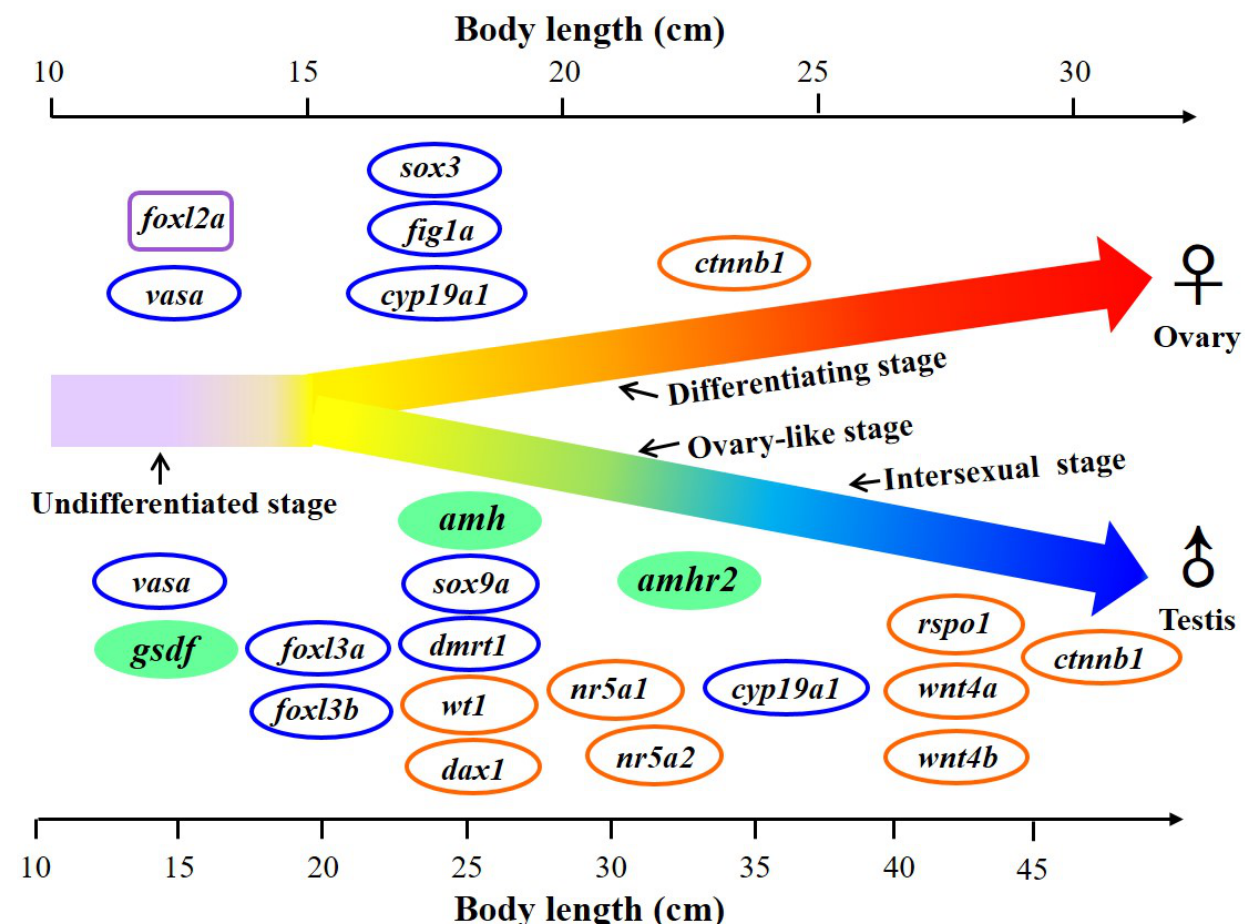
Figure 12. Proposed diagram of the expression of sex-related genes in the gonad during sex differentiation in Japanese eels. The gonadal differentiation occurs during the yellow eel stage at around 20–40 cm body length. E2 was applied to induce the feminization. Ovary-like and intersexual stages were found during the early testicular differentiation. Sex-related genes were sexually dimorphically expressed in the testicular and ovarian tissues. Sex-related genes with increased expression during the process of gonadal differentiation are indicated. The genes gsdf , amh , and amhr2 were investigated in the present study and are marked as green. The genes previously published by Jeng et al. [6] and Wu et al. [69] are marked with blue circles, and the gene previously published by Inaba et al. [78] is marked with a purple square. The genes under investigation by Jeng et al. (unpublished data) are marked with orange circles.